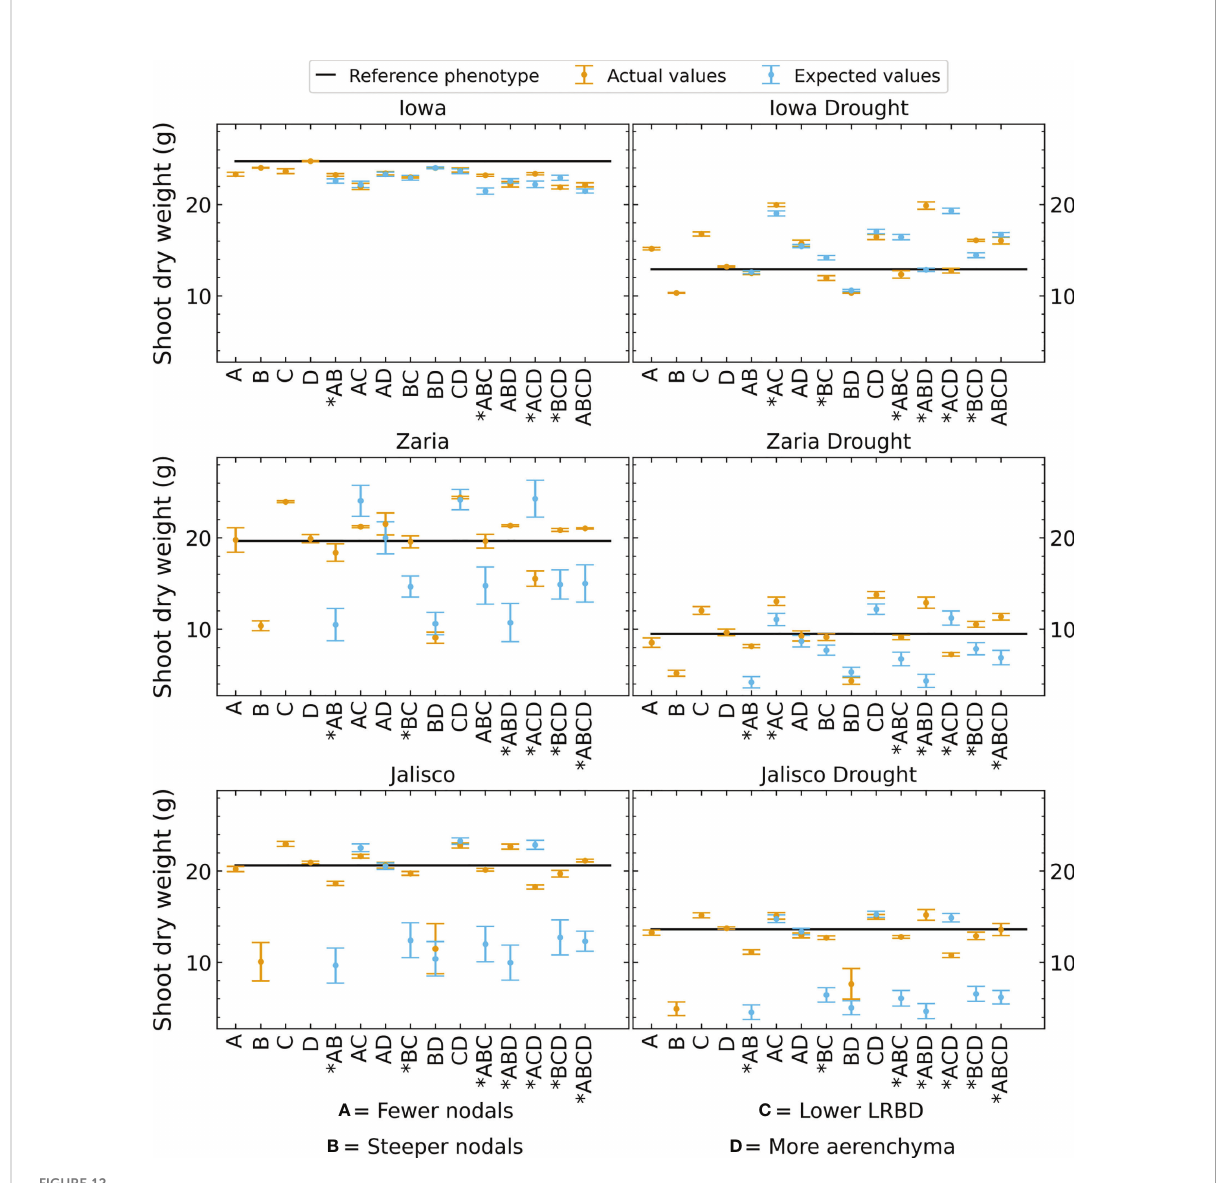
FIGURE 12 Shoot dry weight of phenotypes as expected by adding the changes resulting from altering individual phenes compared to the actual shoot dry weights of these phenotypes. The black line indicates the shoot dry weight of the reference phenotype. The error bars indicate standard error. Cases where the expected and actual shoot dry weight are signi fi cantly different are marked by an asterisk on the x axis